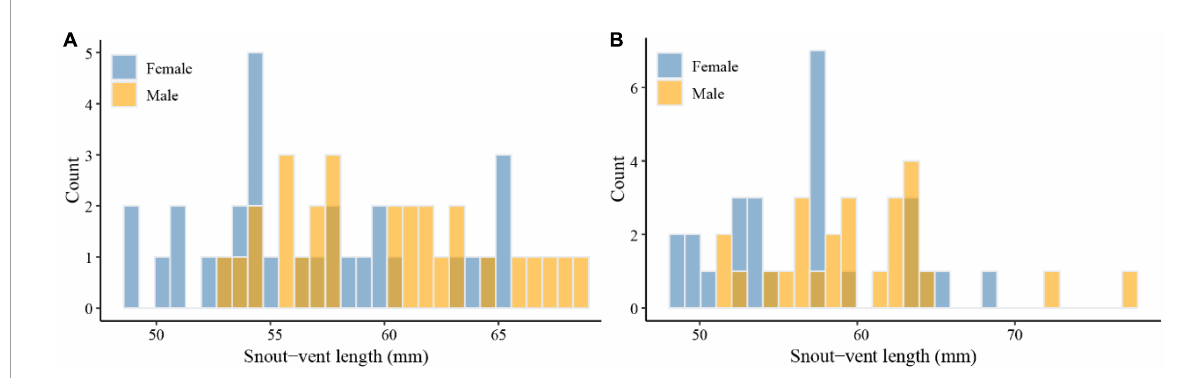
FIGURE2 Frequency plots of snout-vent length of Eremias grammica (A) and Eremias velox (B) .